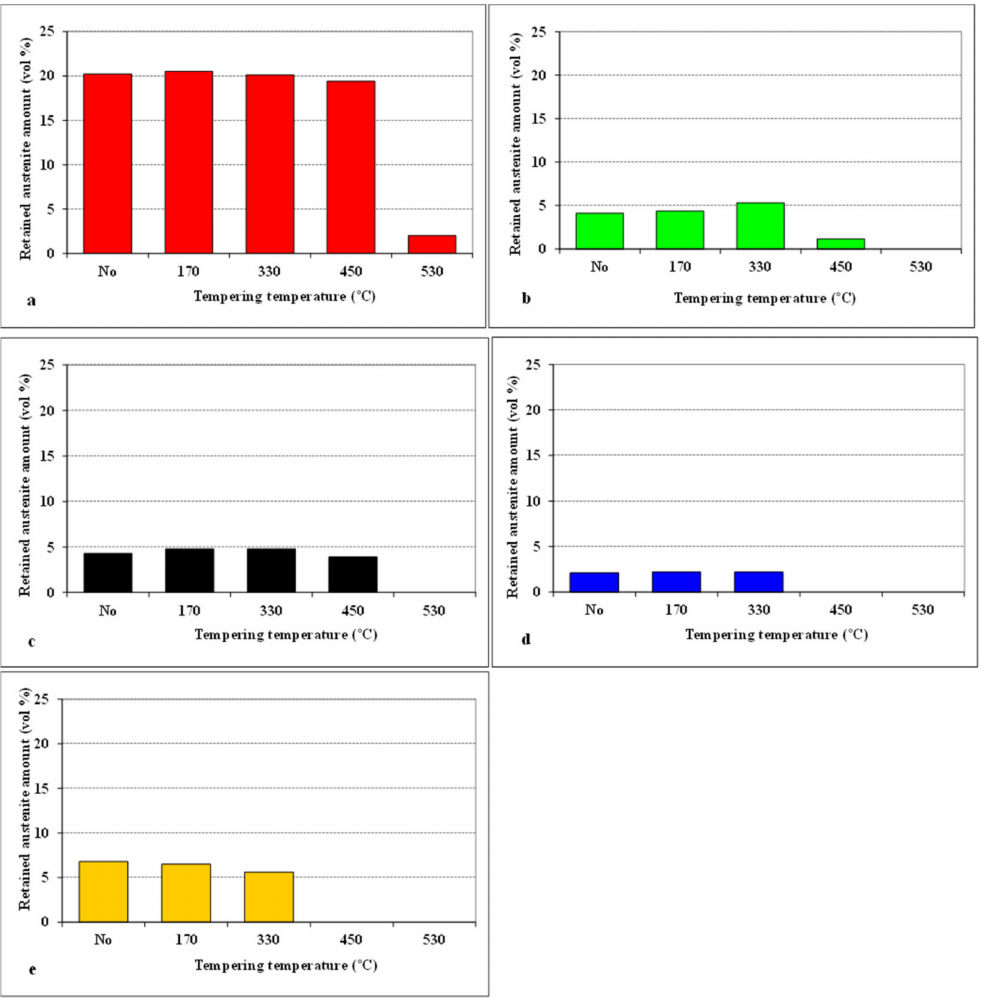
Figure 6. Retained austenite amounts for different SZT specimens, as a function of tempering temperature: ( a ) CHT, ( b ) SZT − 75 ◦ C, ( c ) SZT − 140 ◦ C, ( d ) SZT − 196 ◦ C, ( e ) SZT − 269 ◦